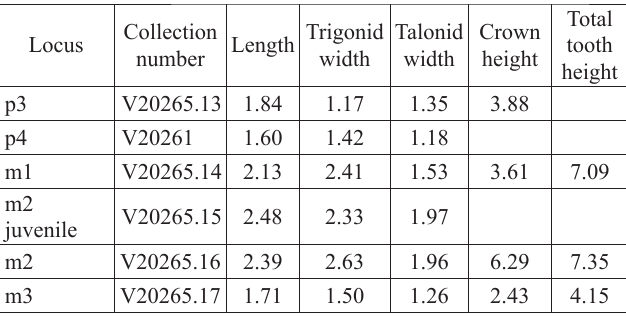
Table 4. Measurements (in mm) of lower teeth of Gobiolagus aliwu- suensis .